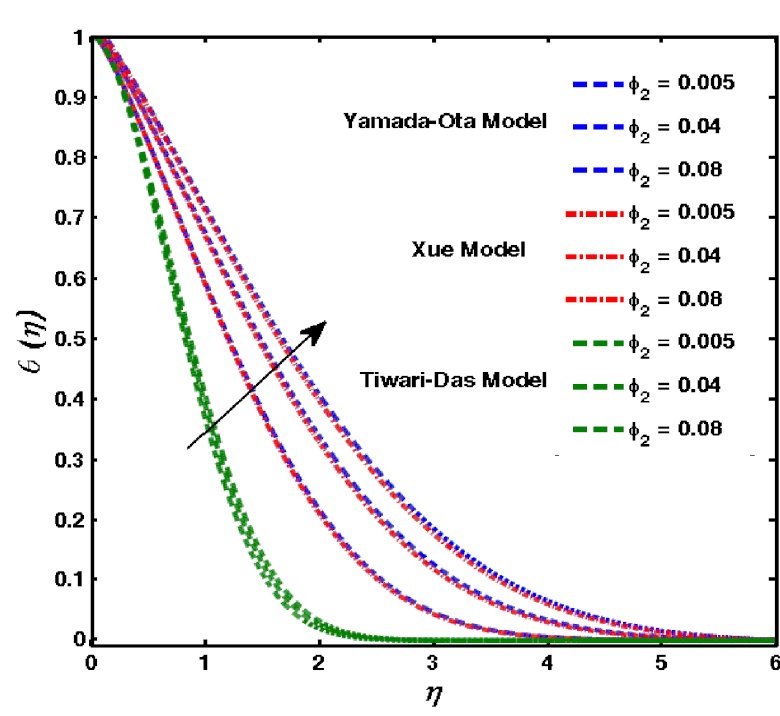
Figure 9. Influence of φ 2 on θ ( η ) when λ =